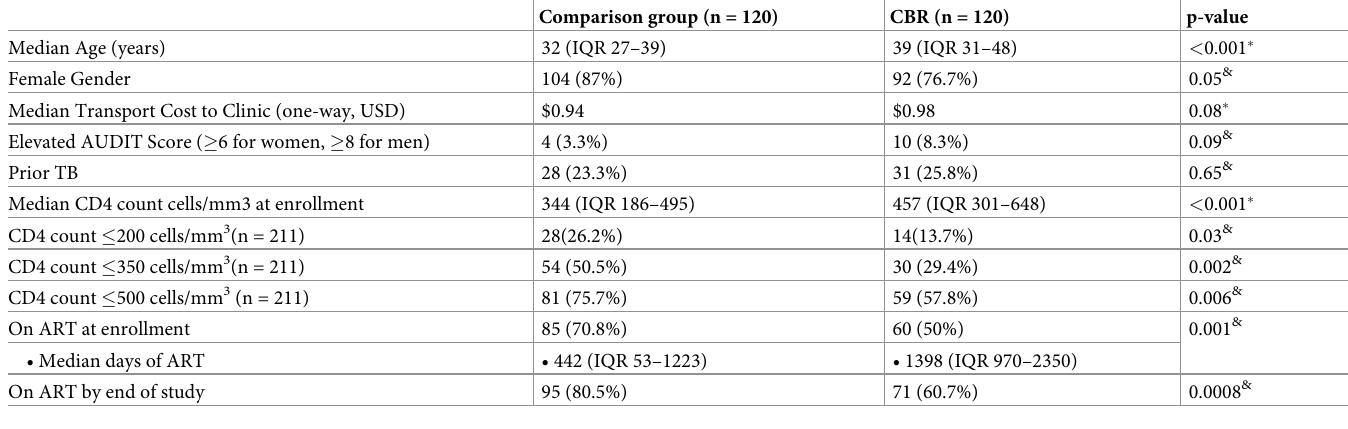
Table 1. Characteristics of study participants (n = 240).